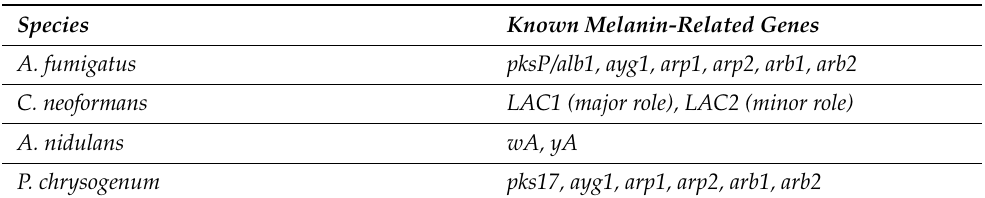
Table 4. Melanin-related genes in A. fumigatus [48], C. neoformans [57], A. nidulans [70], and P. chrysogenum